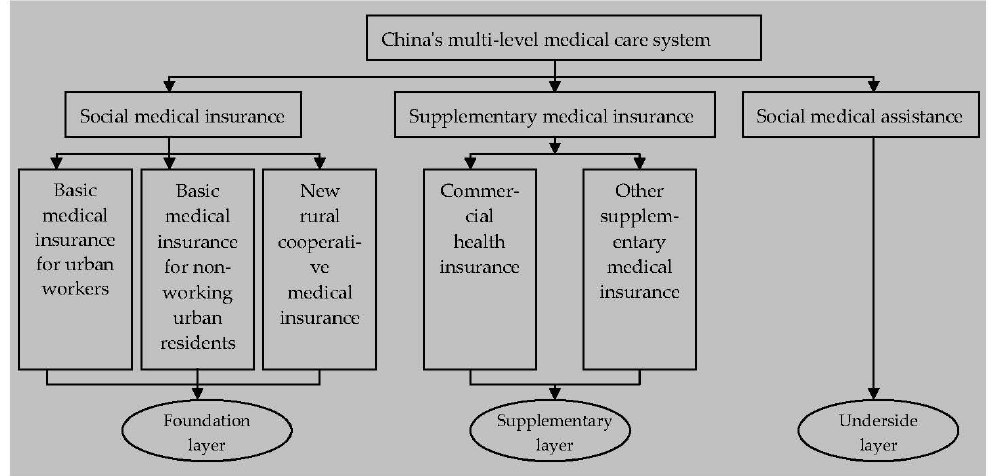
Figure 1. Framework of China’s multi -tiered medical care system.